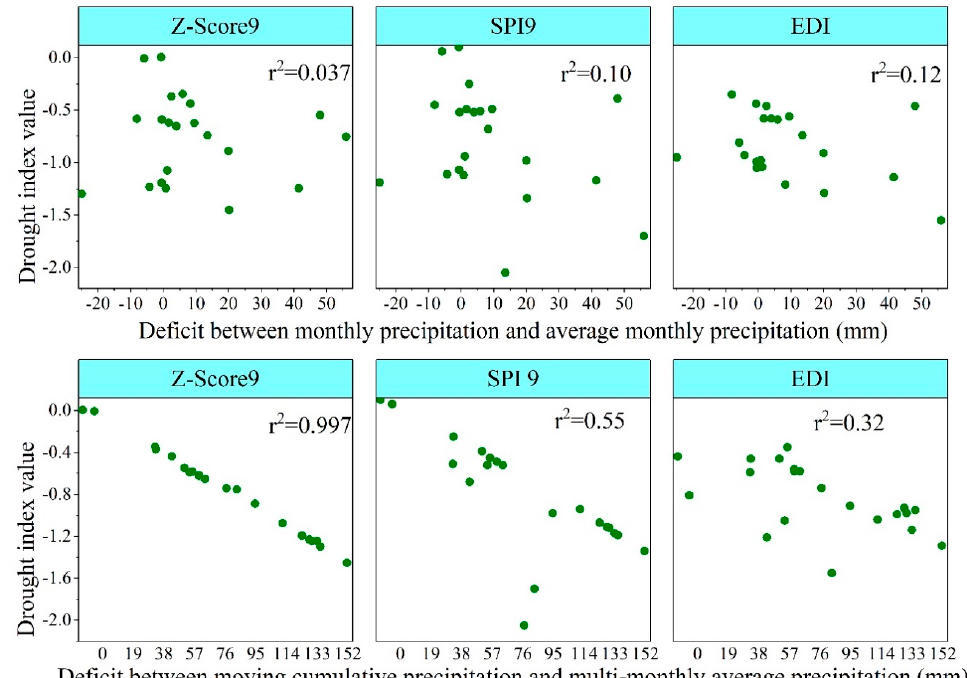
Figure 6. Scatter plots of drought indices (i.e., Z-Score9, SPI9, and EDI) and deficit between monthly precipitation and average monthly precipitation (the first row) and deficit between moving cumulative precipitation and multi-monthly average precipitation (the second row) for the nine-month timestep in Keshan station from September 1999 to May 2001. For the 12-month timestep, multi-monthly average precipitation was relatively high in every month compared to the moving cumulative precipitation at Keshan station (Figure 7). The gap between these two variables was relatively stable from September 1999 to June 2000, and then became larger in July and August, which led to more severe drought conditions. From September 2000, it began to decrease again and reached a stable level until May 2001.